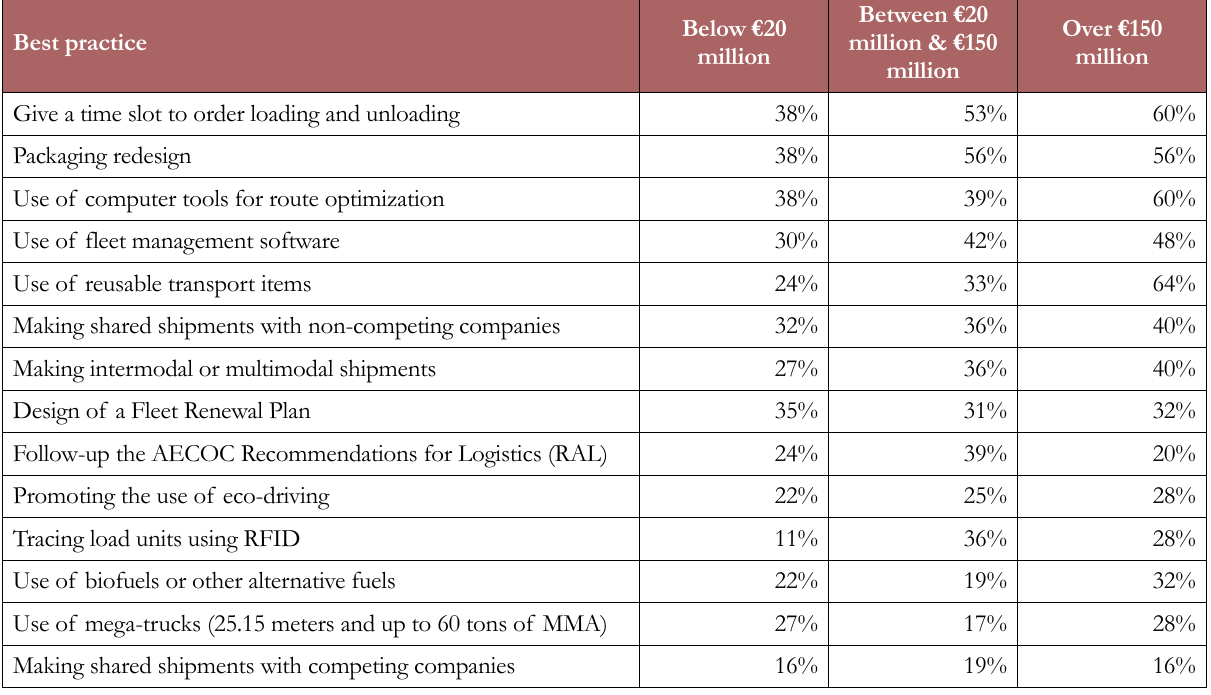
Table 3. Use of best practices by companies’